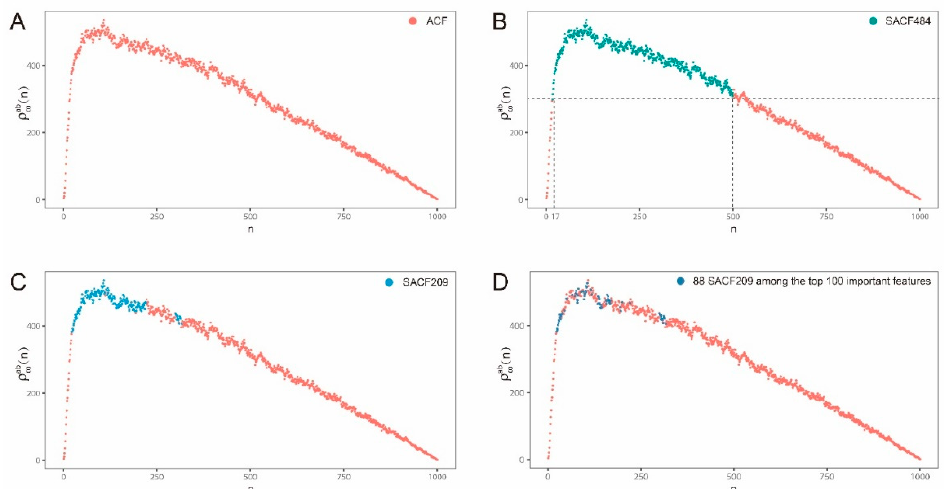
Figure 4. The graph of abelian complexity function and three groups of selected abelian complexity features. ( A ) The original graph of abelian complexity function (ACF); ( B ) The 484 selected abelian complexity features (SACF484, dark green) determined by an upper bound estimation; ( C ) The 209 selected abelian complexity features (SACF209, blue) further determined by Wilcoxon-test; ( D ) The 88 abelian complexity features (dark blue) among the top 100 important features.